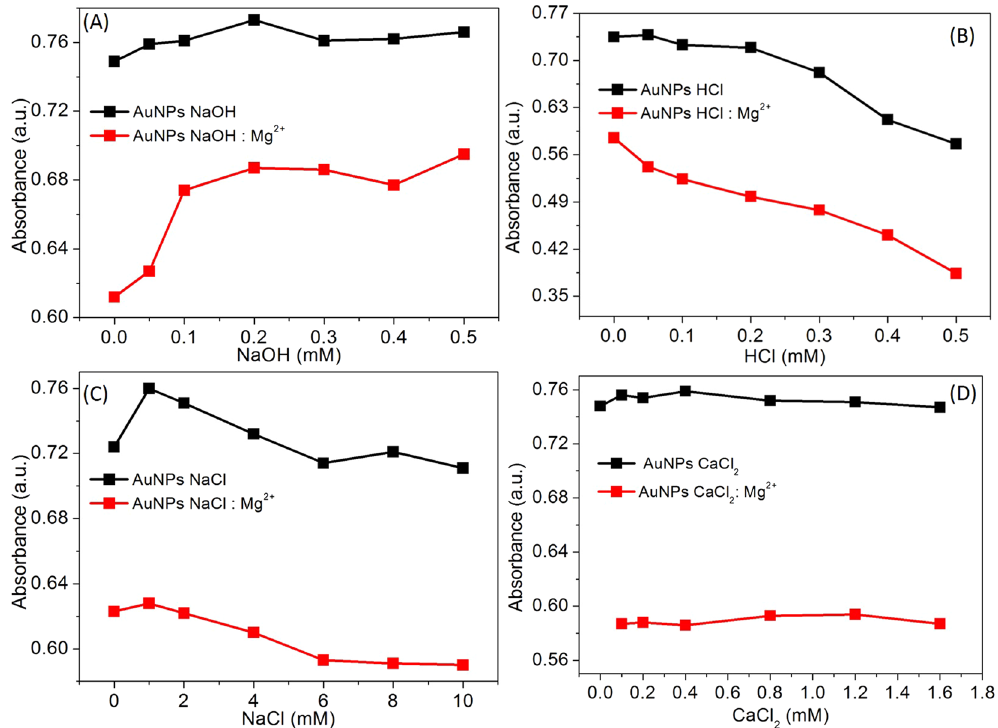
concentrations of Ca 2 + . The absorbance intensity was recorded at 530 nm at ambient